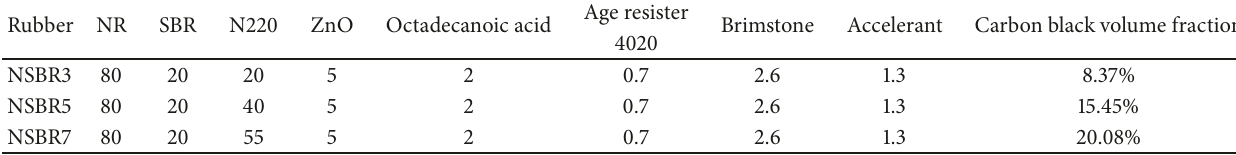
Table 1: Ingredients of carbon black-filled NSBR composites.